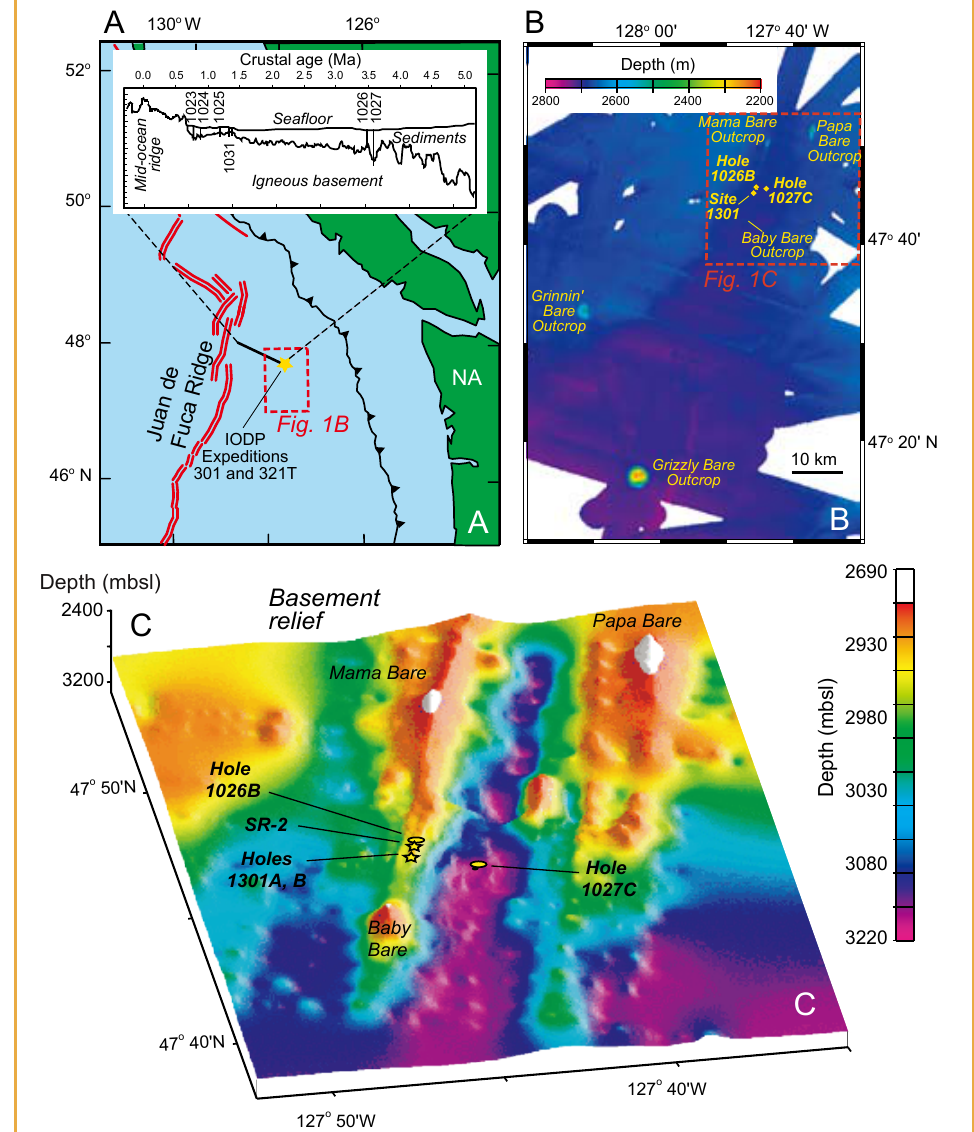
Figure 1. Maps showing the IODP Expedition 301 and 321T field area. [A] Index map showing locations of ODP Leg 168 drilling transect (thick black line), IODP Expedition 301 and 321T work area (gold star), the Juan de Fuca Ridge, and nearby continental areas. Inset profile shows locations of ODP Leg 168 sites. [B] Regional bathymetric map showing locations of ODP Holes 1026B and 1027C and IODP Site U1301. [C] Map of basement relief created from bathymetric and seismic data, showing locations of ODP and IODP drill sites. Areas marked in white are present-day basement outcrops. Figure modified from Zühlsdorff et al.,